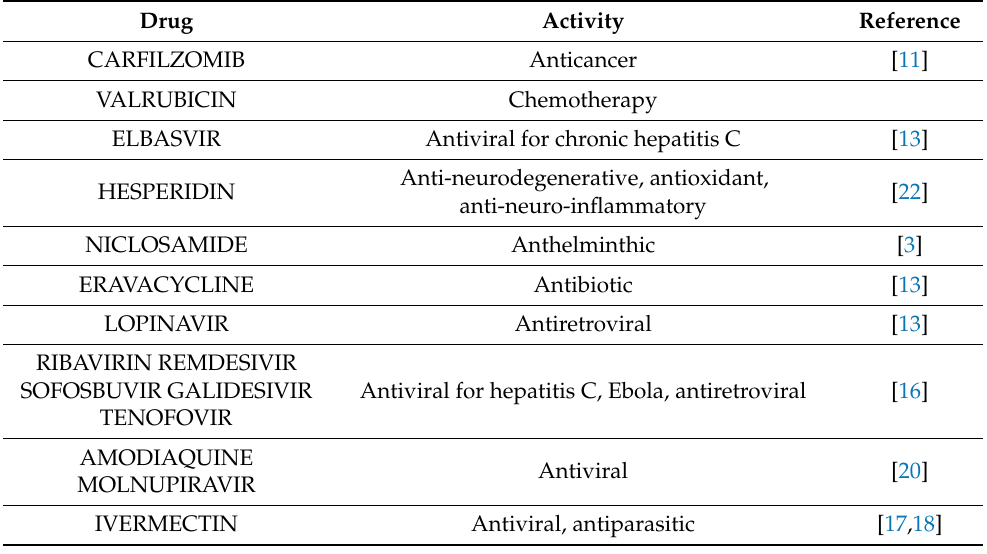
Table 1. Drugs used to control